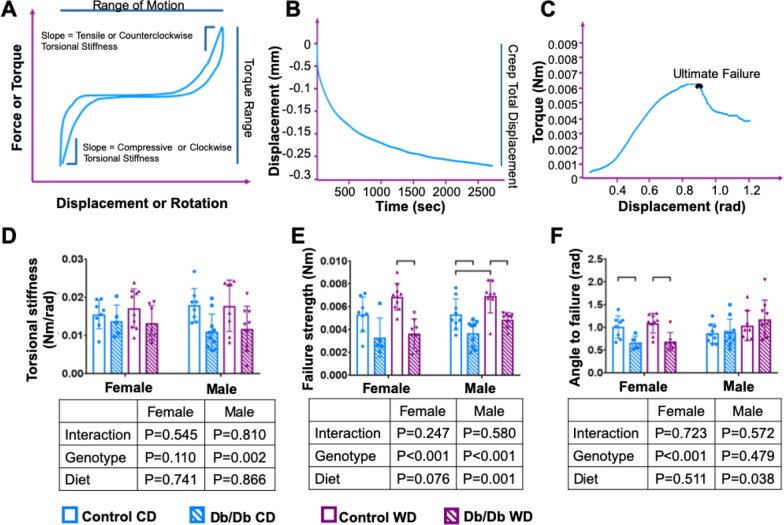
Torsional strength decreased with Db/Db genotype.Schematic curves from A) axial-compression and torsion testing, B) Creep, and C) torsion to failure curves after biomechanical testing analysis. D) torsional stiffness E) Failure strength F) angle to failure. p<0.05.